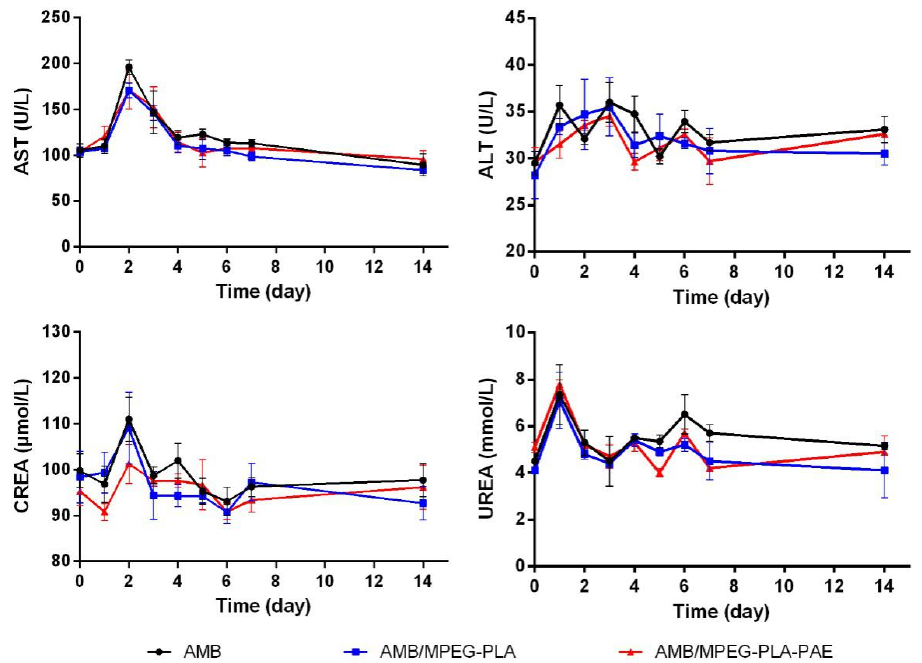
Figure 7. Levels of serum biochemical indicators (AST, ALT, CREA, and UREA) in rats during one-week treatment of various AMB formulations. Six rats each group were used for serum biochemical evaluations at a dose of 1 mg AMB/kg body weight by intravenous administration every day for a week (data represented as the mean ±